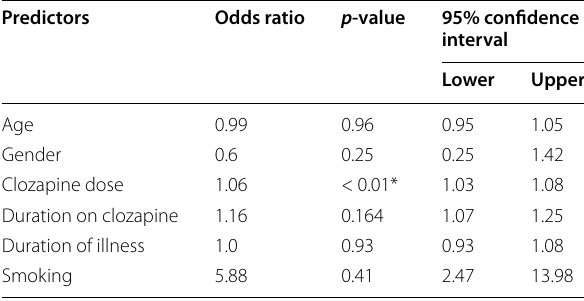
Table 3 Predictors of EEG abnormalities depicted by logistic regression